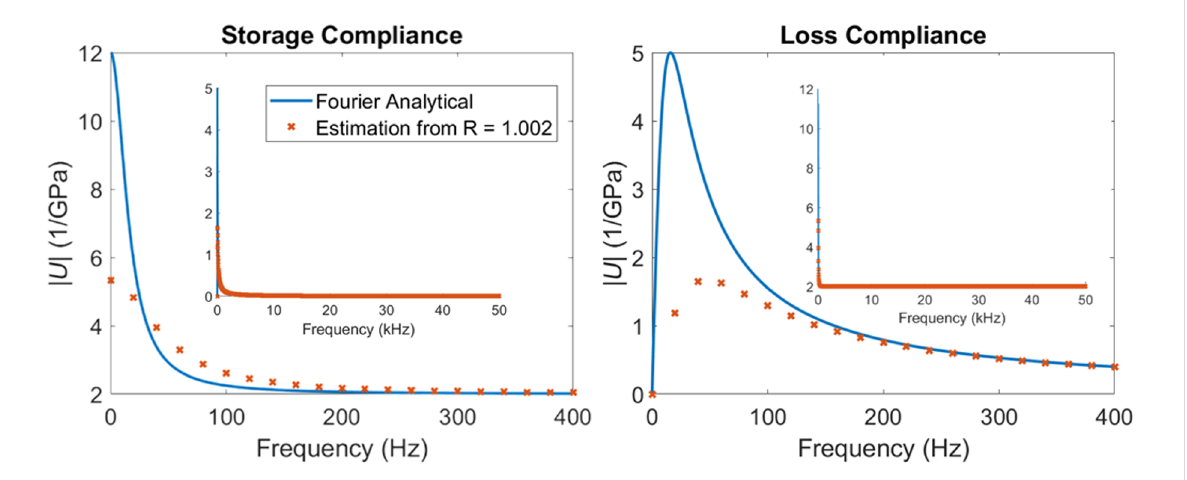
Figure 8: Comparison between the analytical loss and storage compliances for our model material and their estimation from a modified Fourier trans- form evaluated from the Z-transform. For the generalized Voigt model, the modified Fourier transform versions of the loss and the storage compli- ances plotted against frequency exhibit peak values that are reduced by a factor of with respect to the Fourier result, while the width of the peaks is increased by a factor of